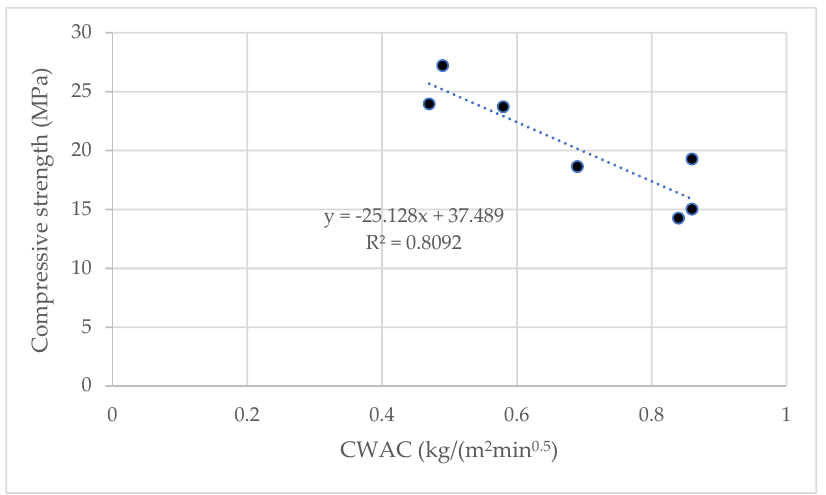
Figure 9. Relation between compressive strength (RC) and the capillary water absorption coefficient (CWAC).